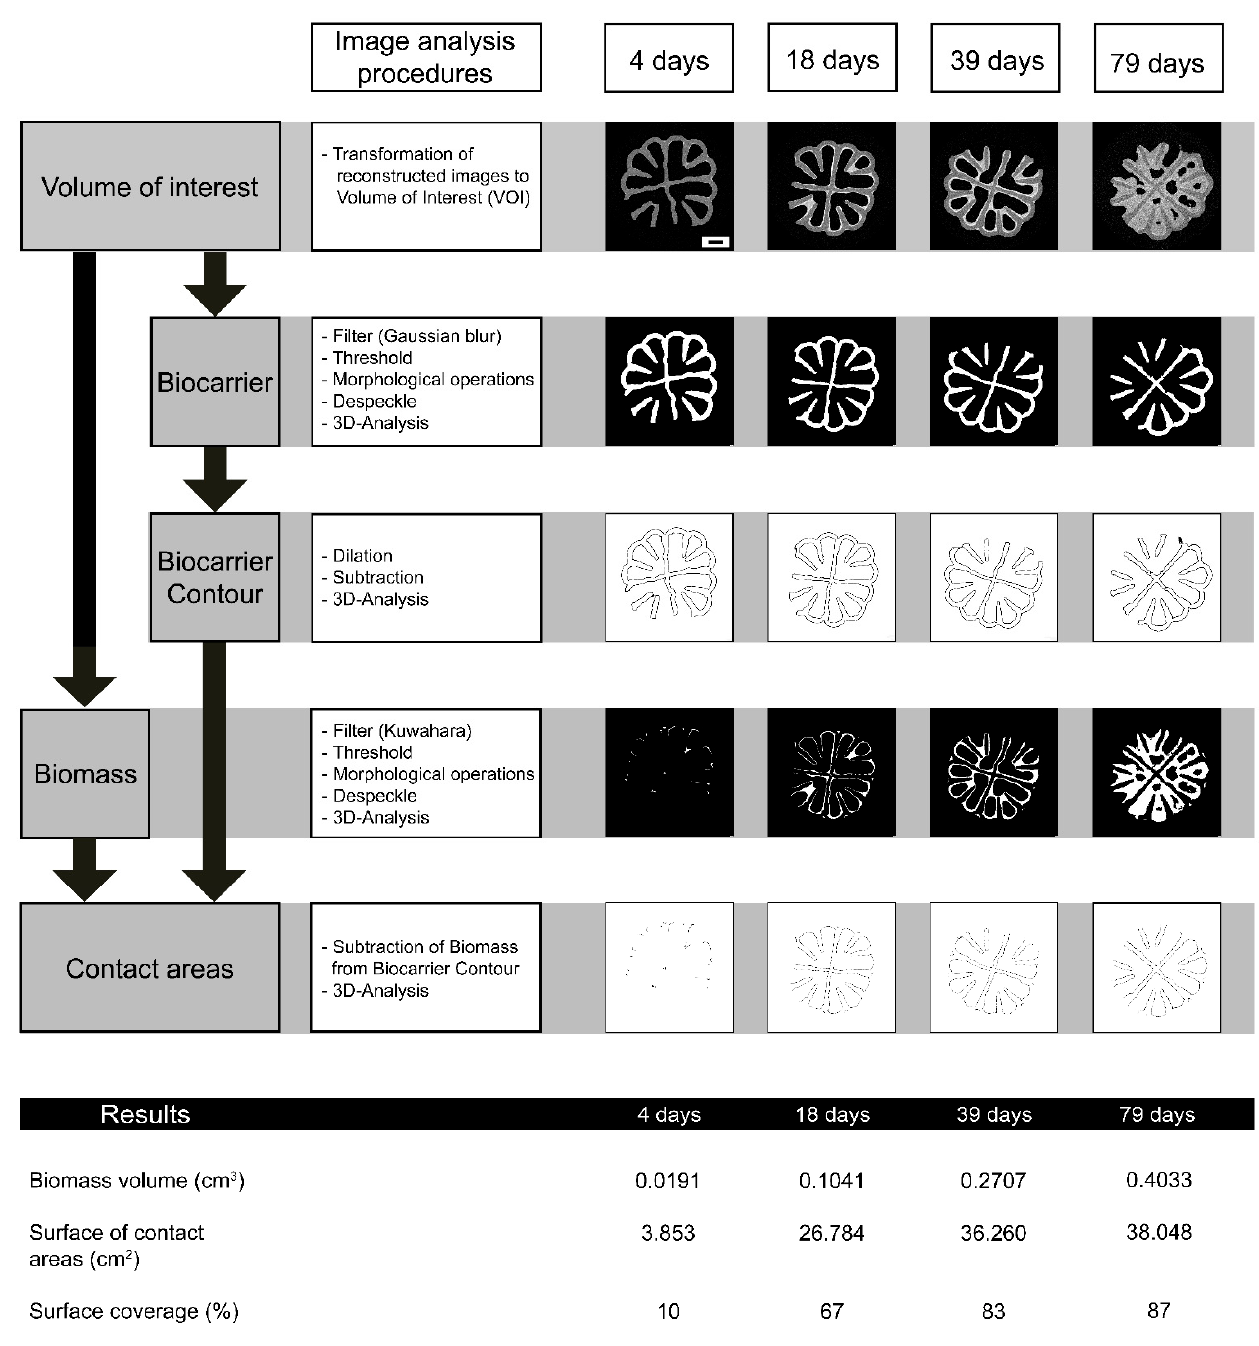
Figure 1. The steps of image analysis and examples of X-ray microtomography ( μ CT). The procedure of image analysis (left part of graphic), where the volume of interest (VOI) is used to determine biocarrier and biomass. The biocarrier can be used to determine its contour. Contact areas can be determined by a combination of biocarrier contour and biomass, as shown in the last lane of white images in this graphic. Here, only one replicate per cultivation is shown with its original image analysis results by one image of the stack. The results were shown for different cultivation times: early cultivation (4 days + 18 days), middle time (39 days), and late times of cultivation (79 days). Note: The images of biocarrier contour and contact areas were inverted due to better visibility. Finally, some resulting numbers are shown beneath the contact areas. Here, increasing biomass volume and surface coverage with rising cultivation time are also shown. Scale bar (on VOI image of 4 days) corresponds to 2 mm.